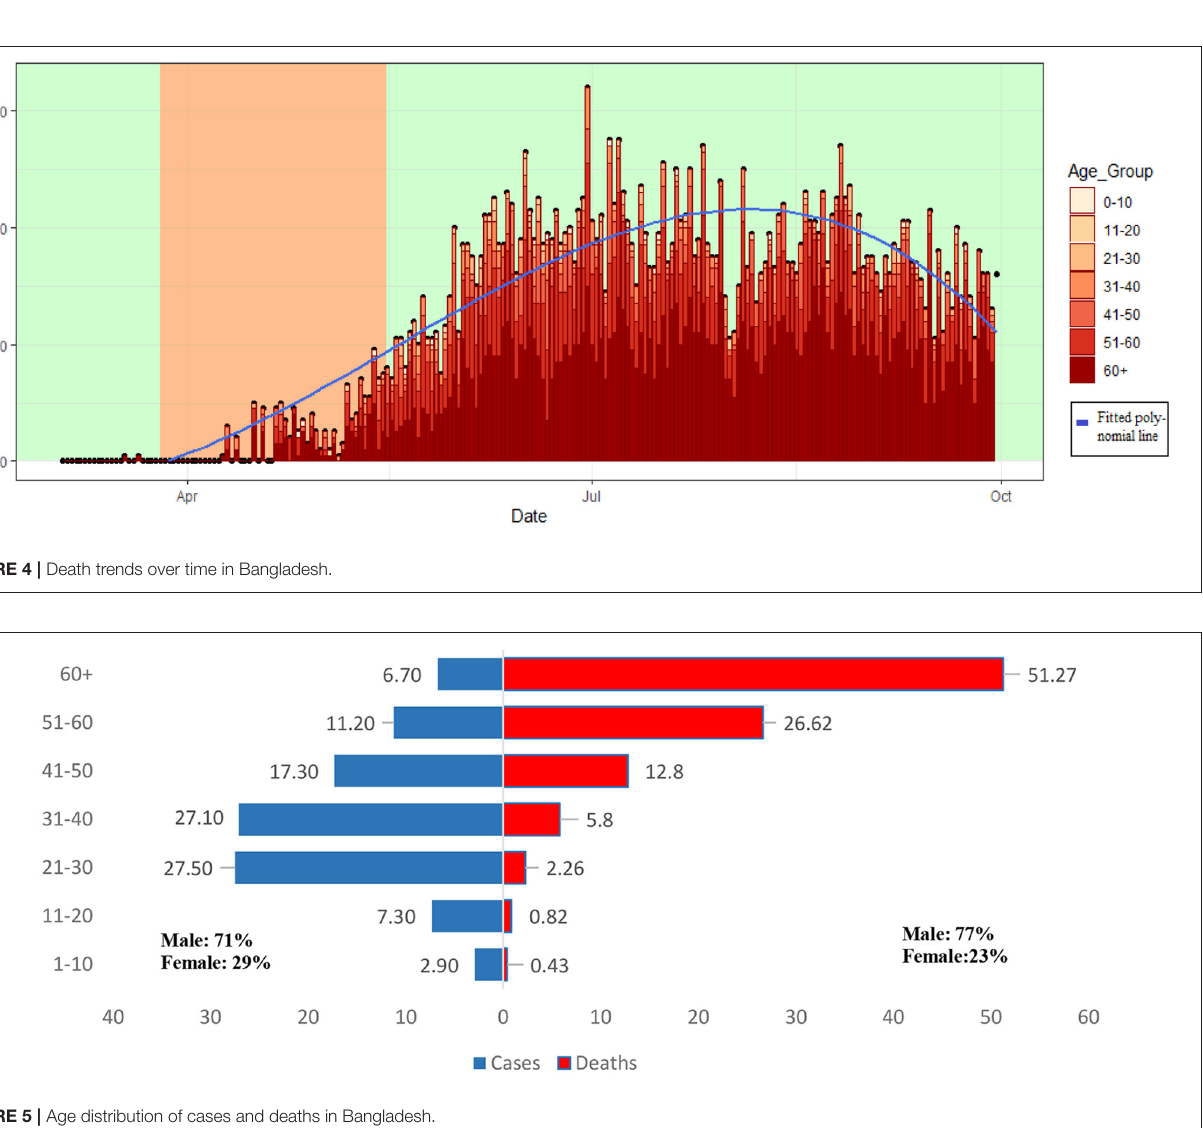
the seaports, and 7,029 passengers in the cantonment railway station